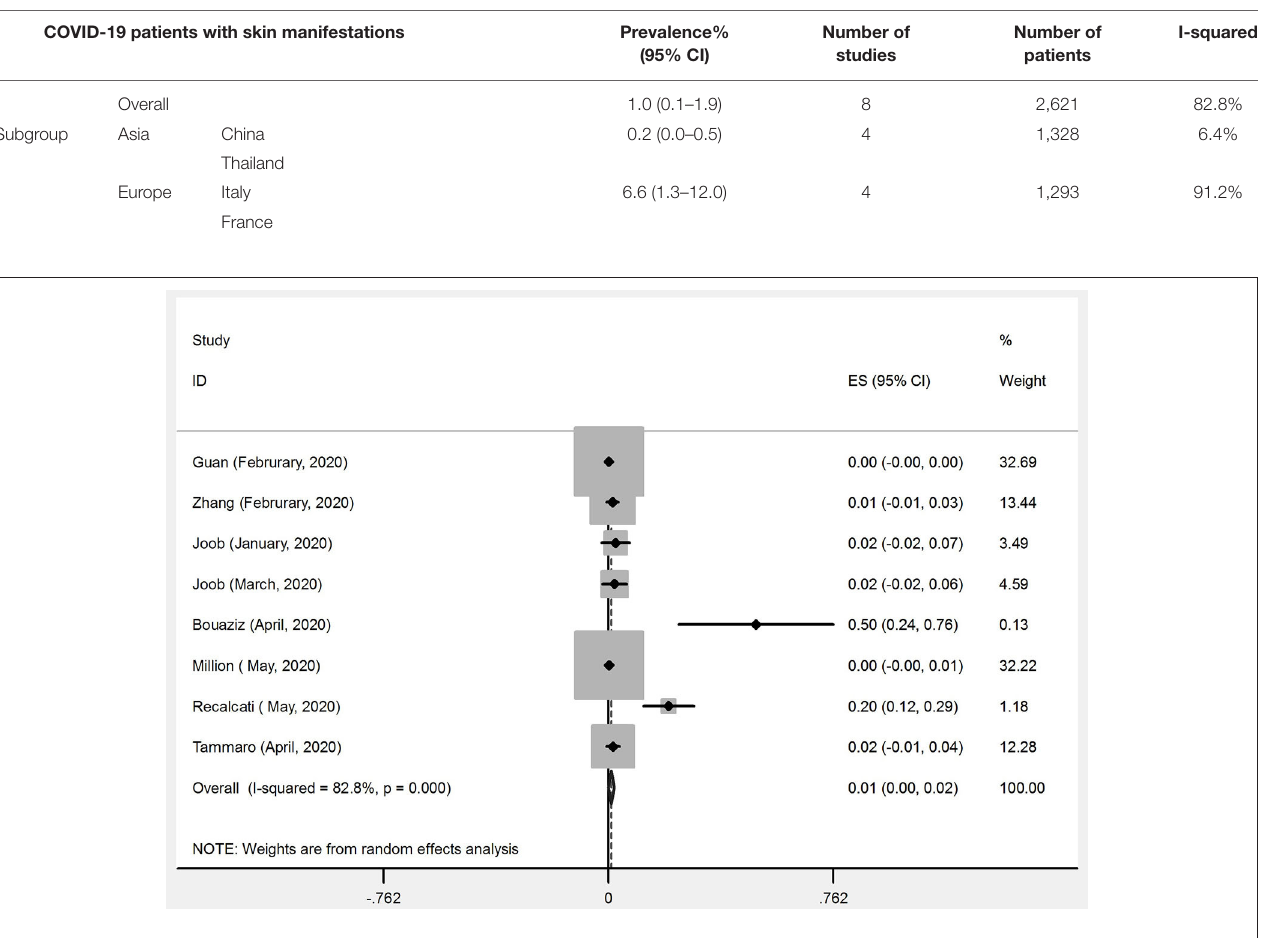
FIGURE 2 | Forest plot of the meta-analysis on the prevalence of skin manifestations among patients with COVID-19.